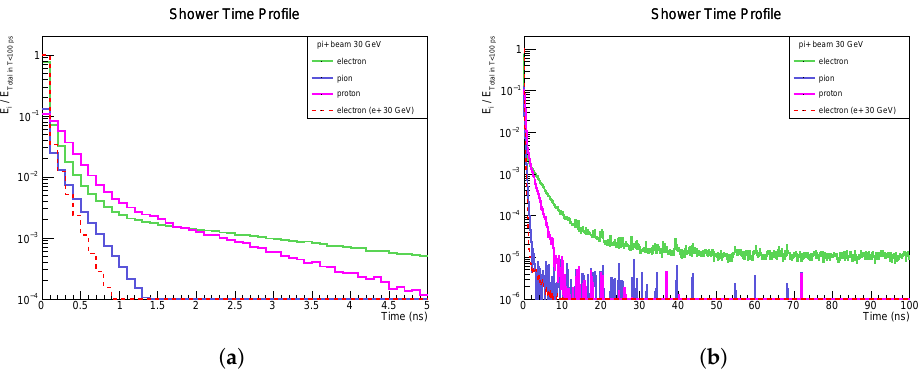
Figure 1. Time structure of hadronic showers in a sampling calorimeter composed of 17 mm Cu ab- sorber with 3 mm silicon layer as active material. The time is the calorimeter local time, t = t G 4 − z / c , which is corrected for the travel time along the z -axis for all particles. ( a ) ( t < 5 ns) is a zoomed-in view of ( b ) ( t < 100